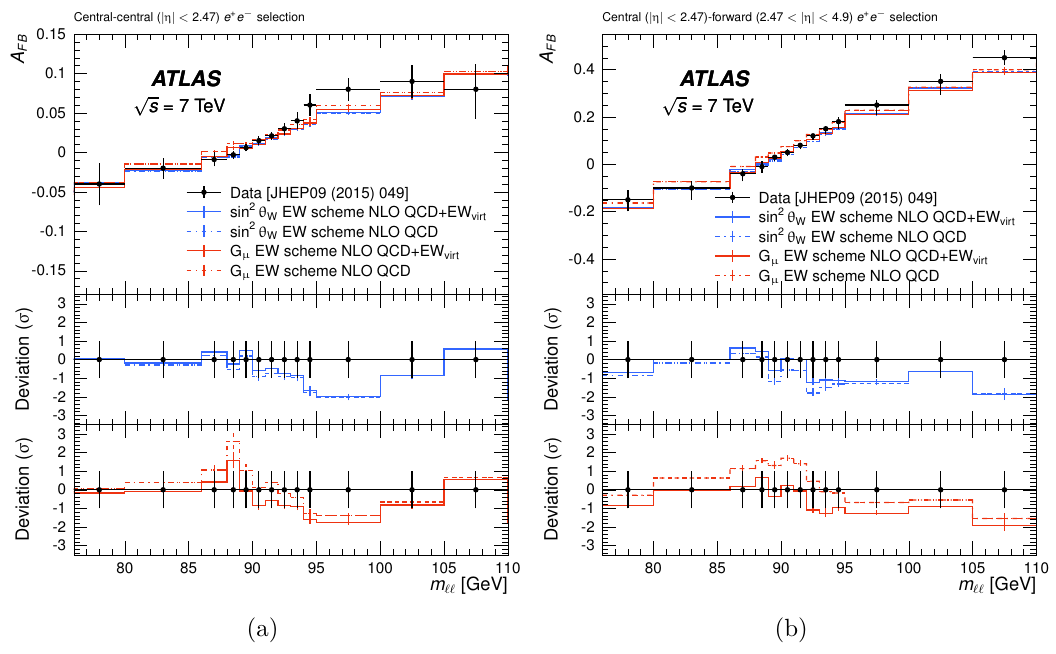
for the G and sin 2 θ electroweak input FB µ eff